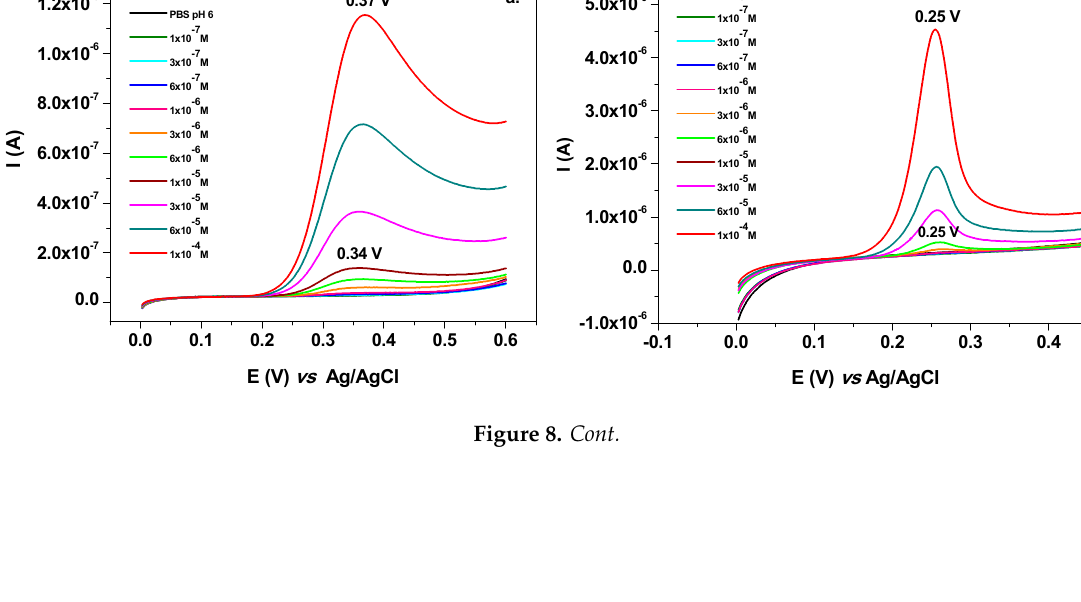
Figure 8. LSVs recorded with SPE ( a ) and SPE-Gr ( b ) in pH 6 PBS solutions containing various concentrations of 8-OHdG (1 × 10 − 7 –1 × 10 − 4 M); comparison between the SPE and SPE-Gr signals at one selected 8-OHdG concentration (1 × 10 − 4 M in pH 6 PBS) ( c ); 10 mV/s scan rate. By representing the oxidation peak signal (Ipeak) vs. 8-OHdG concentration, the corresponding calibration plot for each electrode was obtained (Figure 9). The sensitivity of SPE-Gr (0.035 A/M) was four times higher than that of SPE (0.0084 A/M). In addition, it had a wider linear range (3 × 10 − 7 –1 ×10 − 4 M in comparison with 6 × 10 − 7 –1 × 10 − 4 M) and lower limit of detection (LOD = 9 × 10 − 8 M in comparison with 1.8 × 10 − 7 M; S/N = 3.3). Although the screen-printed electrodes are normally designed for single-use, we evaluated the time stability of SPE and SPE-Gr by performing calibration measurements on different days. After each measurement, the electrodes were thoroughly washed with distilled water and then kept dry at room temperature. It became clear that the reproducibility was relatively poor in the case of SPE electrode (RSD 11.5%) possible due to the adsorption of the oxidation products on its surface. In comparison, SPE-Gr had an excellent reproducibility (RSD < 3%). The results of several repetitive experiments confirmed that the graphene material had an excellent adhesion to the electrode surface and consequently, the modified electrode had good reproducibility and